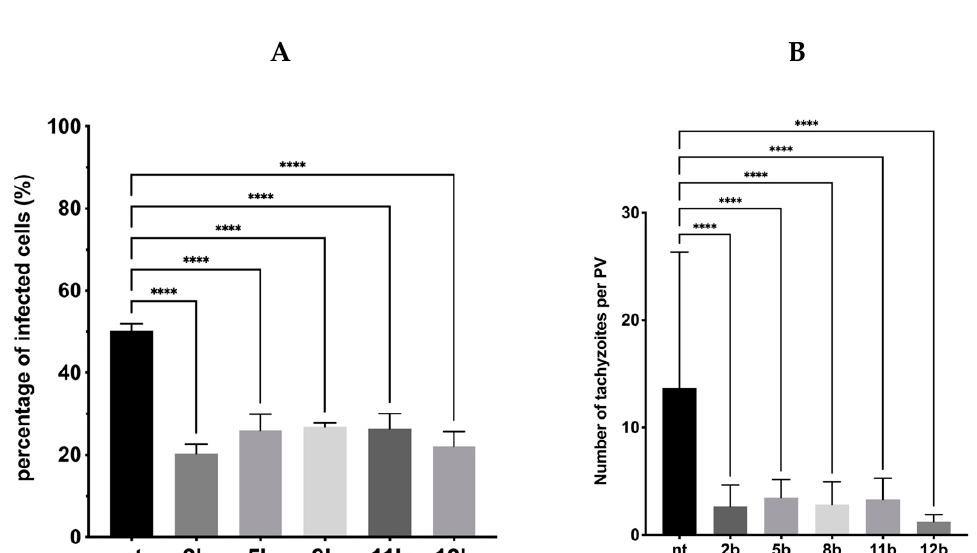
Figure 7. Representative images from Assay A. Host cells infected with tachyzoites for 3 h in the milieu of the 1,3,4-thia- diazoles 2b , 5b , 8b , 11b or 12b and then washed, incubated for 24 h in free medium; T. gondii— green, cell nuclei—blue; NT—non-treated.